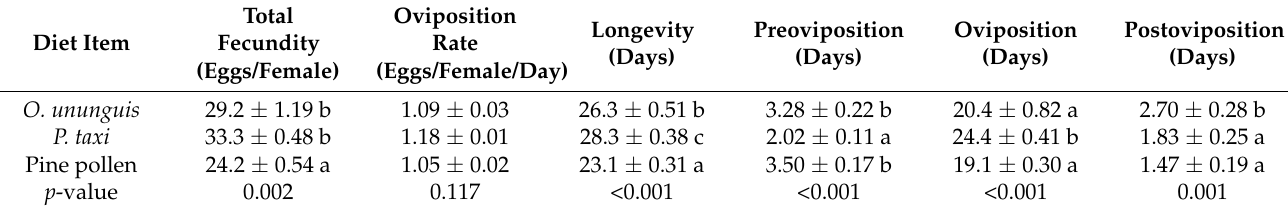
Table 2. Amblyseius andersoni female reproductive parameters and longevity (mean ± SE). Values with different letters in a column differ significantly at p ≤